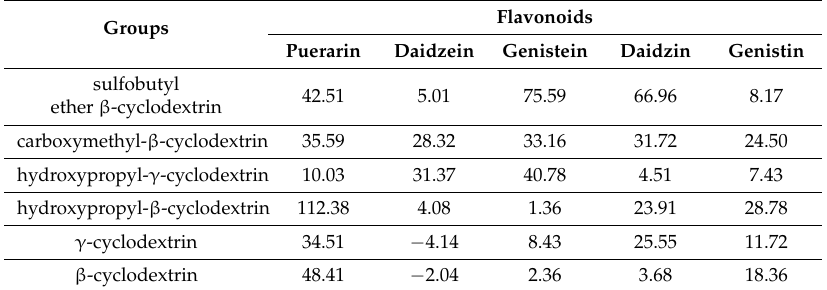
Table 2. Extraction growth rate of flavonoids in PLR